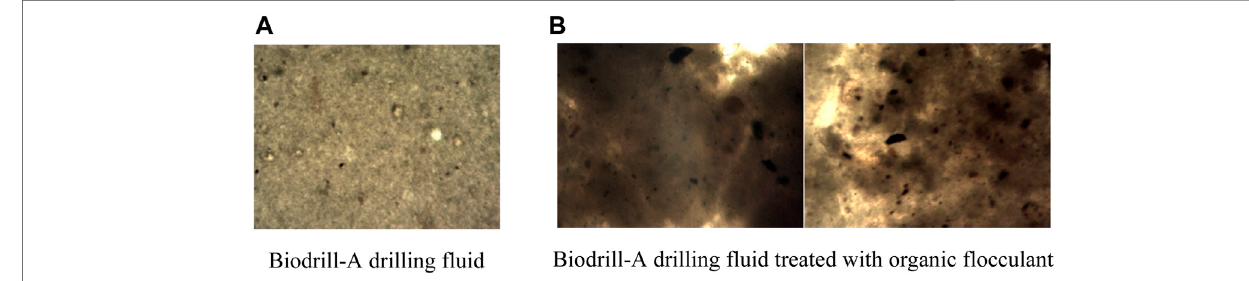
FIGURE 6 | Microscopic morphology of Biodrill-A drilling fl uid under the microscope after organic fl occulant treatment.